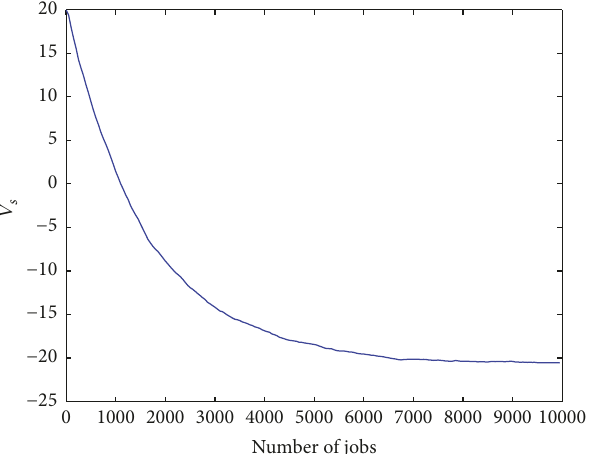
Figure 5: The Learning Curve of weighted throughput